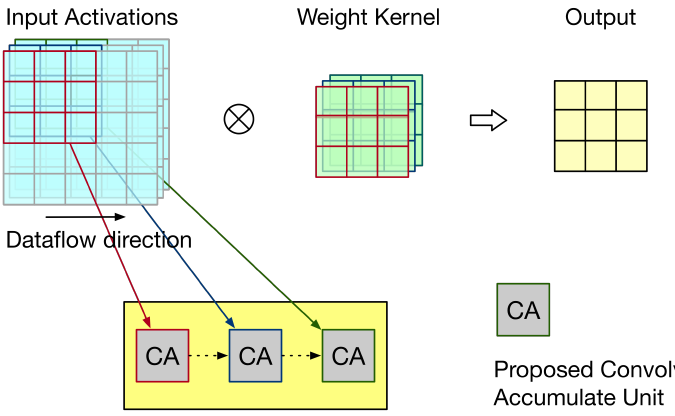
Figure 15. An illustration for weight stationary